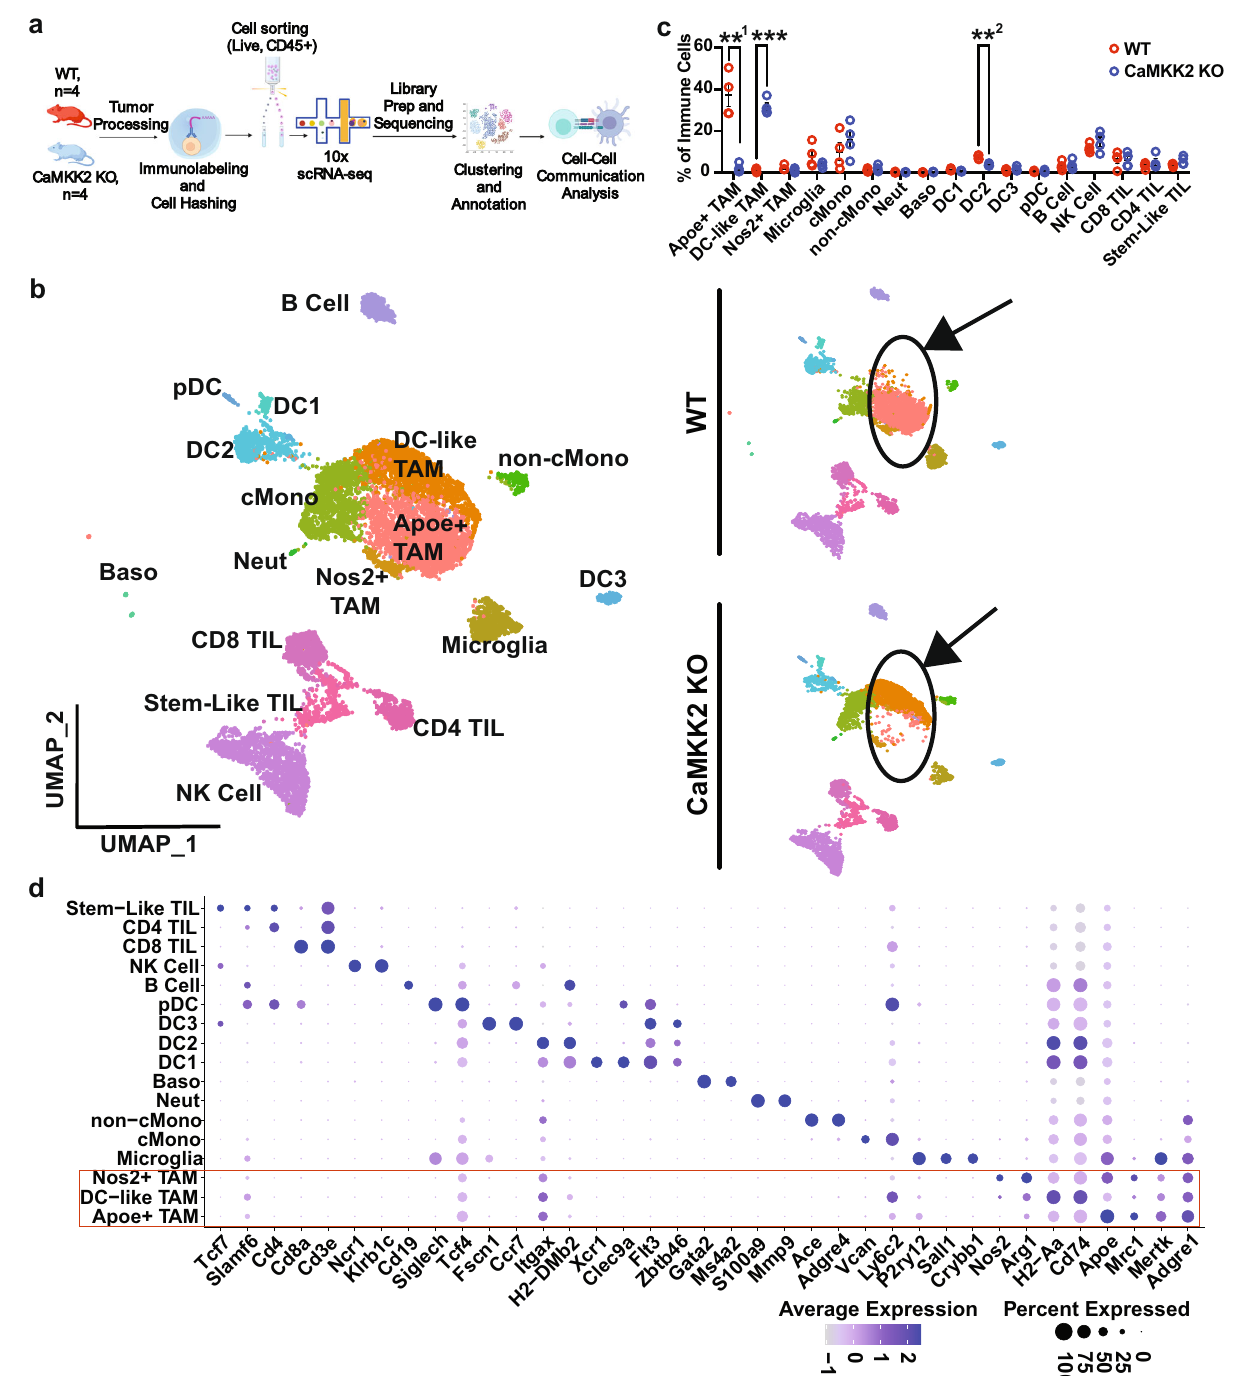
Fig. 2 | Pro-tumor immune programming in the glioma microenvironment is CaMKK2dependent.a SchematicdepictingscRNA-seqexperimentaldesign. n =4 WT and CaMKK2 KO mice had 50k CT2a orthotopically implanted. On D14 tumors wereharvestedandunderwenttumorprocessing.SampleswerelabeledwithaLive- Dead viability Dye, CD45, and TotalSeqB anti-mouse Hashtag antibodies. CD45 + Live cells were sorted, and then pooled in equal parts by genotype. Graphic was created with BioRender.com. b 14k CD45+ Live Immune cellsweresorted from WT andCaMKK2KOtumor-bearinghemispheresonD14p.i.HTOandGeneExpression libraries were prepared using the 10X platform. UMAP plots of the cell types